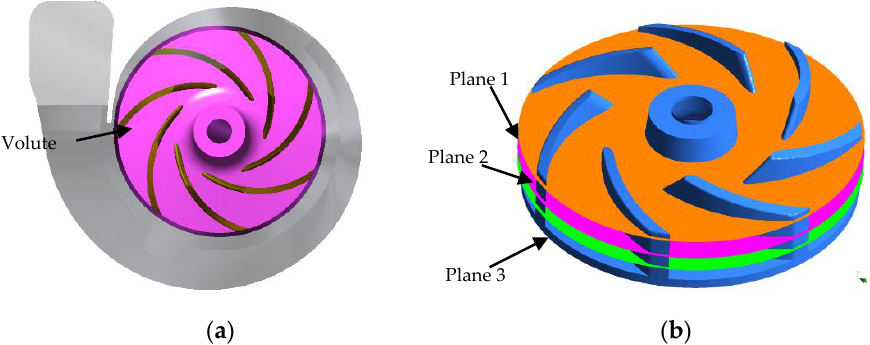
Figure 11. Location of blade cross section: ( a ) Relative position of blade and volute tongue ( b ) Three blade cross sections.